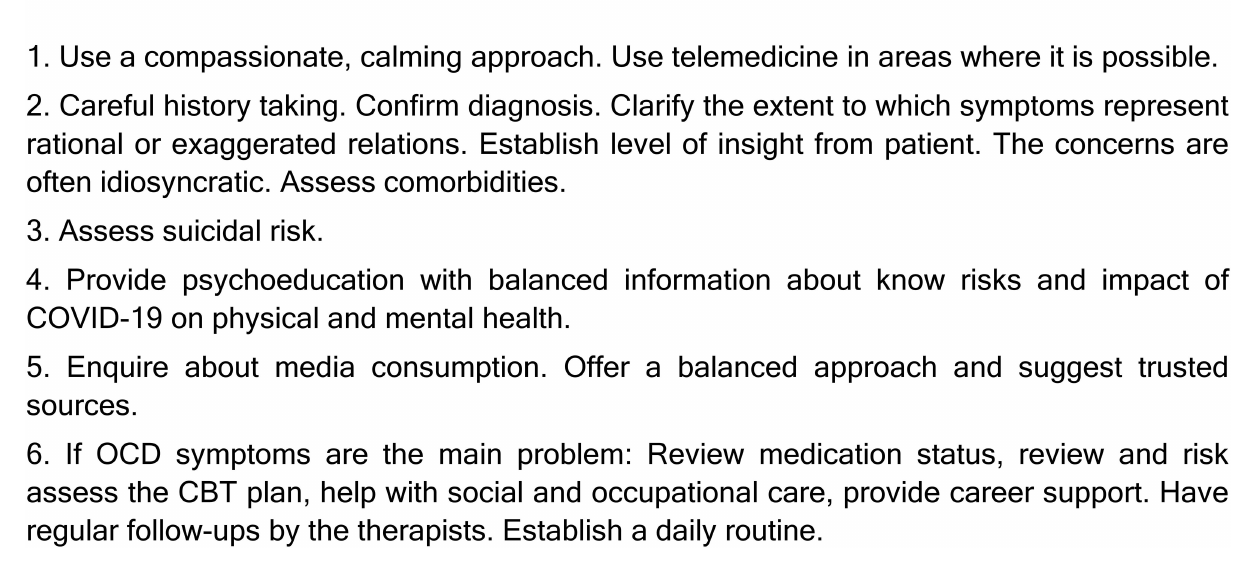
FIGURE 2 | Clinical guidelines for the treatment of obsessive-compulsive disorder during the COVID-19